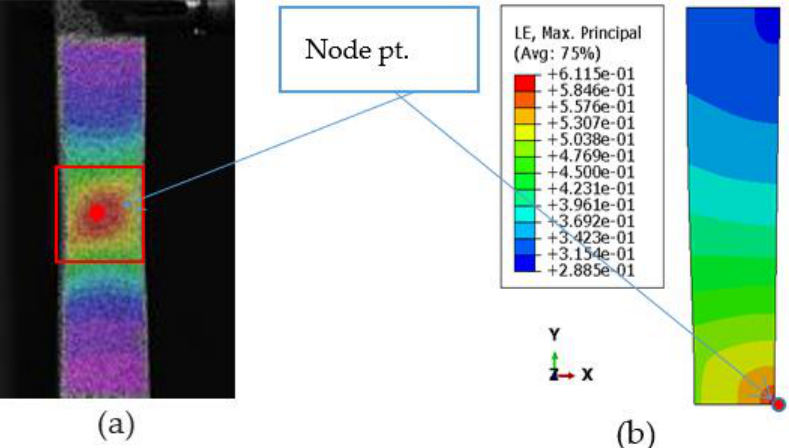
Figure 6. Tensile test: images of the specimen; ( a ) distribution of strain along length (via digital image correlation (DIC)) and ( b ) logarithmic strain distribution just before